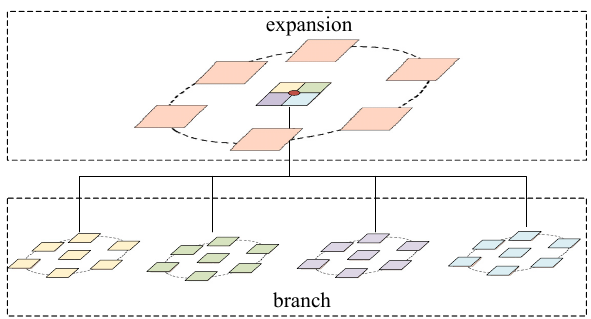
Figure 7. The schematic of the expansion and branch for the